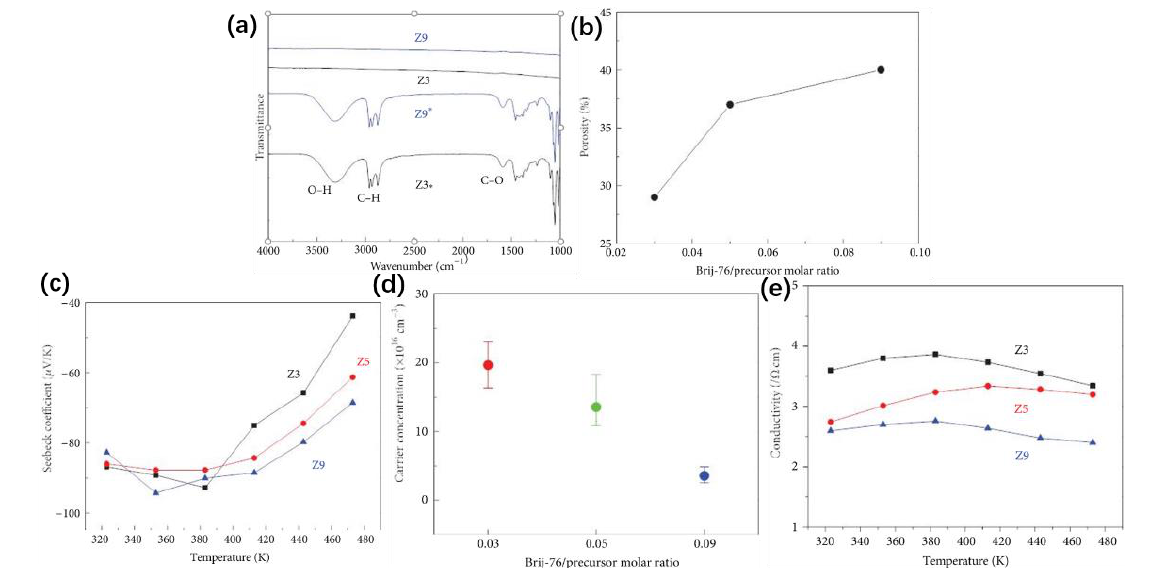
Figure 15. ( a ) Fourier transform infrared spectroscopy spectra of mesoporous ZnO thin films pro- duced using various surfactant concentrations before annealing (Z3* and Z9*) and after annealing (Z3 and Z9) at 450 °C. ( b ) Porosity, ( c ) Seebeck coefficient, ( d ) carrier concentration, and ( e ) electrical conductivity changes in mesoporous ZnO thin films synthesized using various surfactant concen- trations. Copyright © 2013 Min-Hee Hong.